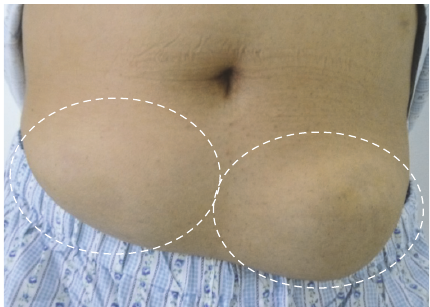
Figure 1: Physical examination of the affected area: two subcuta- neous masses were present, each measuring 50 mm, in the left and right subumbilical regions, with minor subcutaneous hemorrhage and tenderness (indicated by broken-lined ovals).